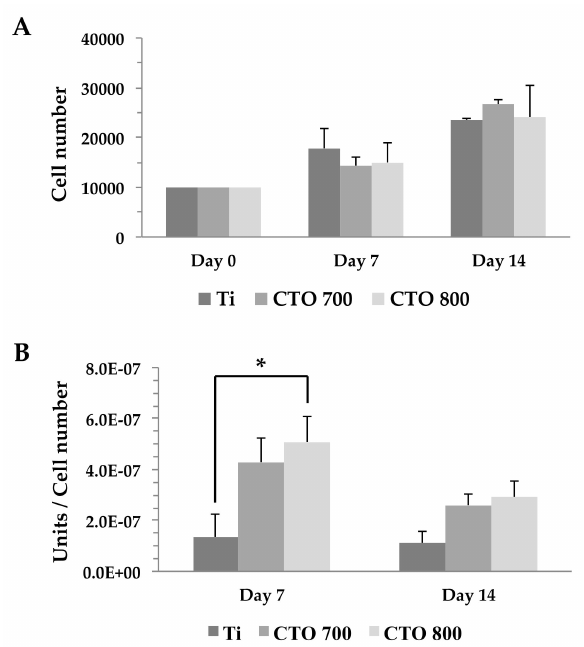
Figure 5. ( A ) Cell proliferation assay; and ( B ) alkaline phosphatase activity. Data are mean ± standard deviation ( n =